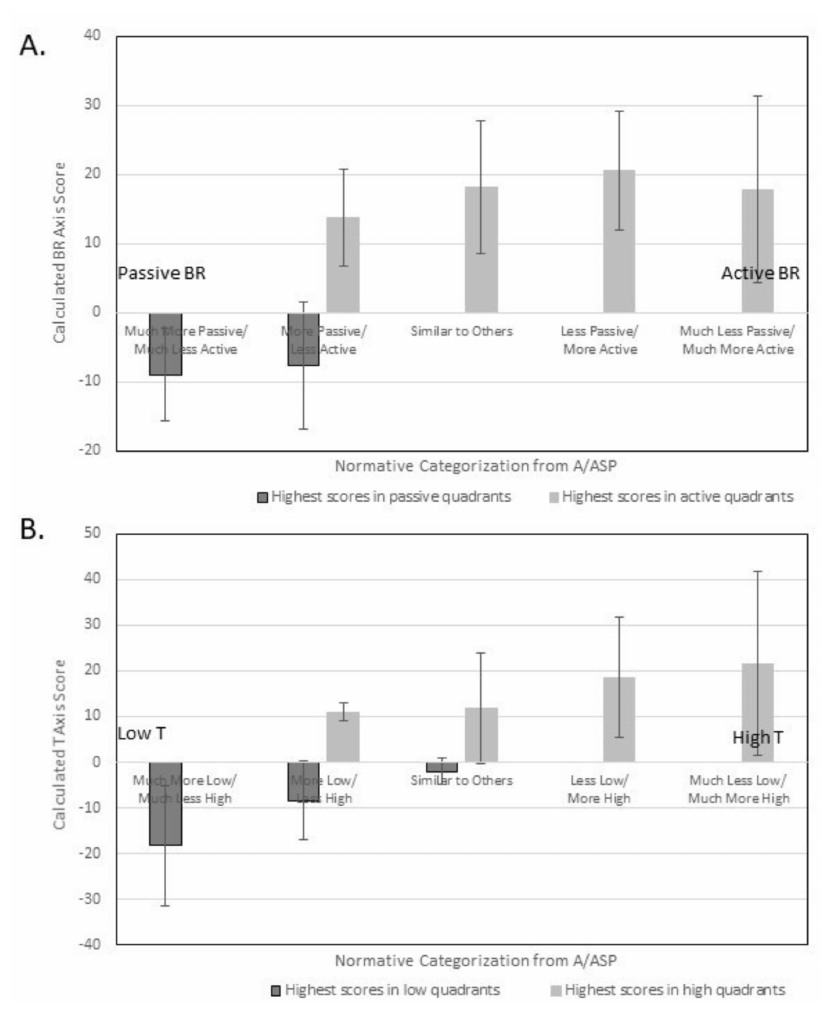
Figure 1. Calculated axis scores for participants according to the quadrant in which they had their highest score on the A/ASP. ( A ) Given the quadrant in which participants had their highest score on the A/ASP, participants were categorized into Passive BR and Active BR, then further divided according to how their score compared to the normative distribution. This bar chart shows the mean and deviation of calculated BR axis scores, arranged along the passive to active spectrum of the axis. The means do not increase from passive to active in an ordinal fashion. ( B ) Given the quadrant in which participants had their highest score on the A/ASP, participants were categorized into Low T and High T, then further divided according to how their score compared to the normative distribution. This bar chart shows the mean and deviation of calculated T axis scores, arranged along the low to high spectrum of the axis. The do demonstrate ordinal increase along the low to high